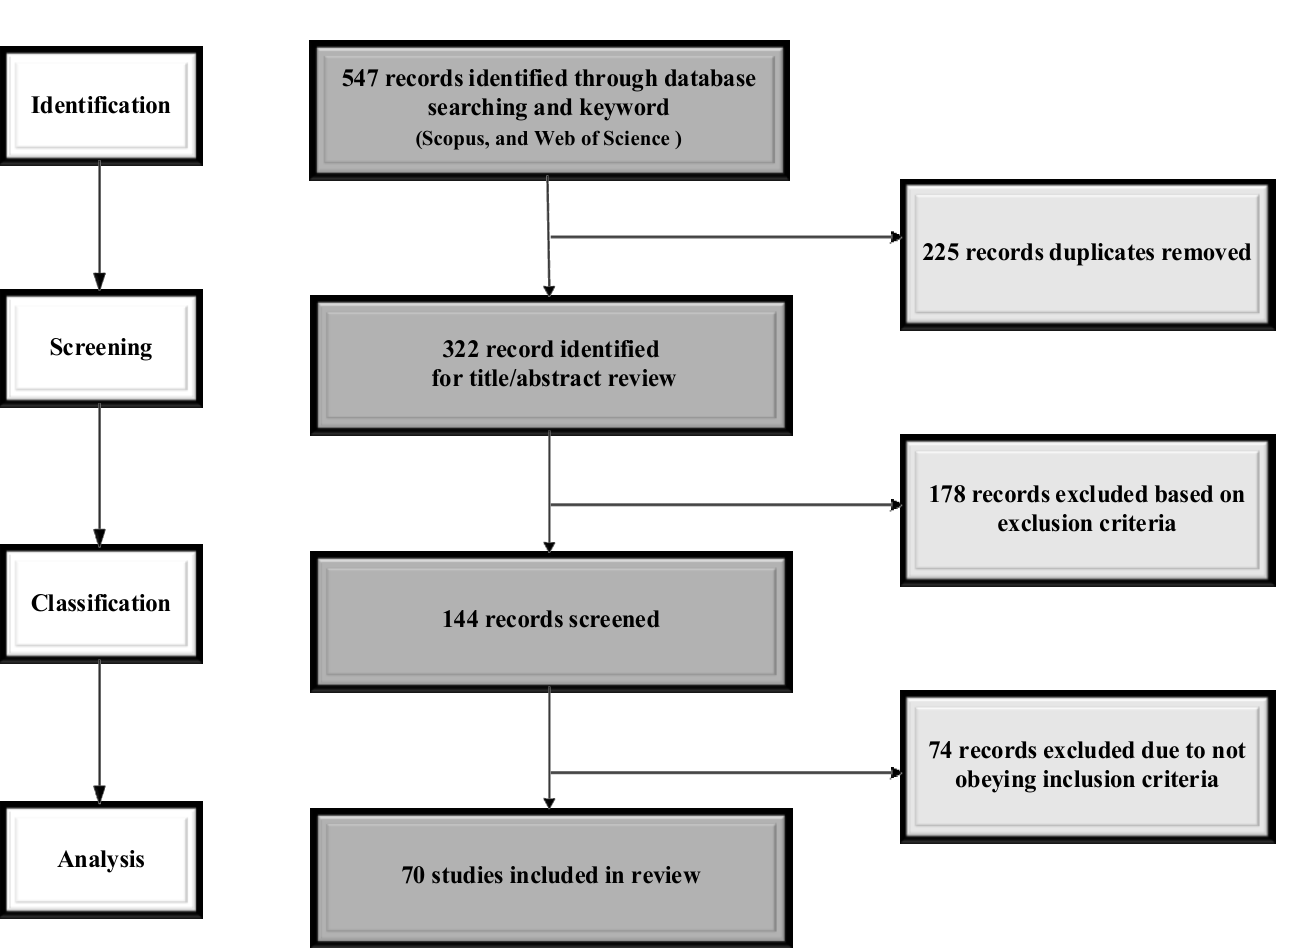
Figure 2. PRISMA flowchart with the process applied in this research.